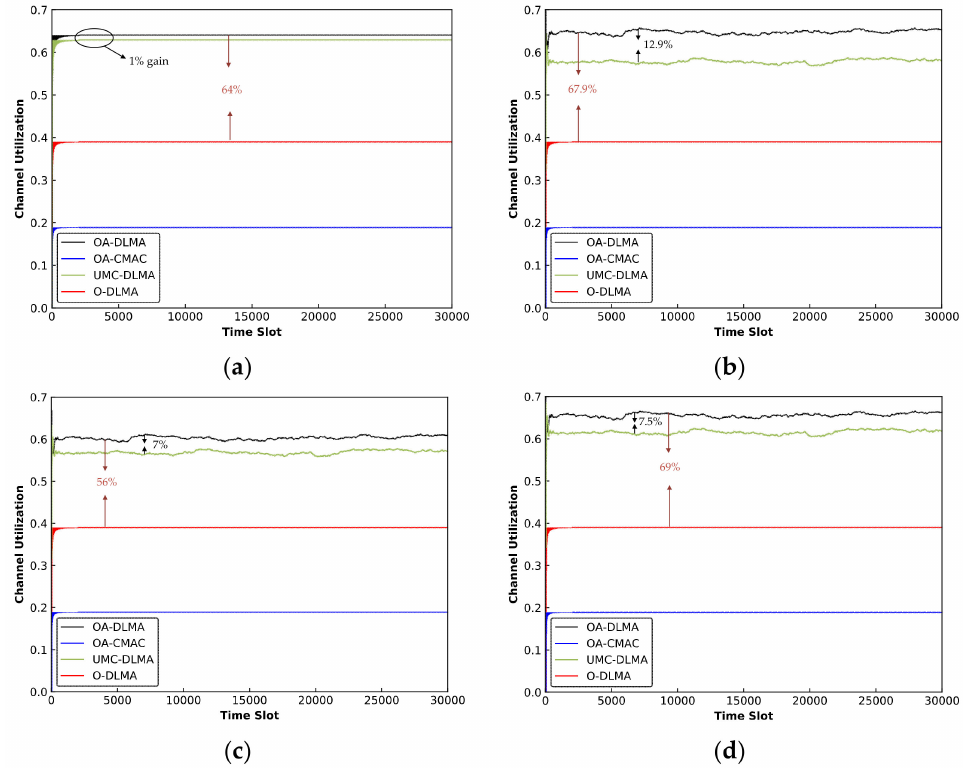
Figure 13. Channel Utilization of the network with multiple source nodes using four MAC protocols (i.e., O-DLMA, OA-DLMA, OA-CMAC, and UMC-DLMA). The transmission probability q of ALOHA nodes in ( a ), ( b ), ( c ), and ( d ) is 0, 0.3, 0.5, and 0.7,